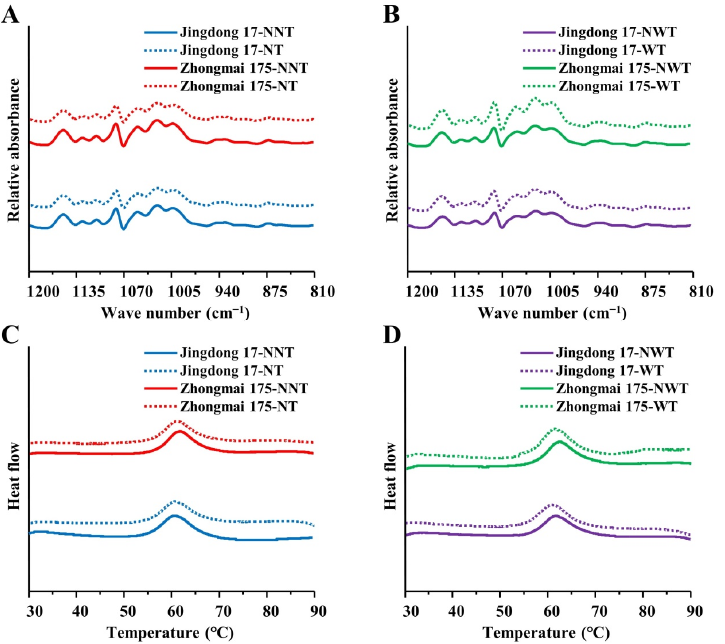
Figure 3. ATR ‐ FTIR and DSC analyses of starch granules. Spectra of ATR ‐ FTIR analysis of starch extracted from Zhongmai 175 and Jingdong 17 at non ‐ nitrogen (NNT) and reduced nitrogen (NT) treatments ( A ), non ‐ water (NWT) and reduced water (WT) treatments ( B ); DSC thermograms of gelatinization properties for starch extracted from Zhongmai 175 and Jingdong 17 at NNT and NT ( C ), NWT and WT ( D ).